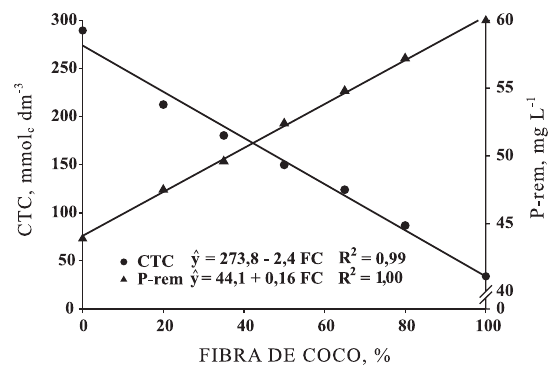
Figura 1. CTC e P remanescente (P-rem) em função da porcentagem de fibra de coco (FC) no